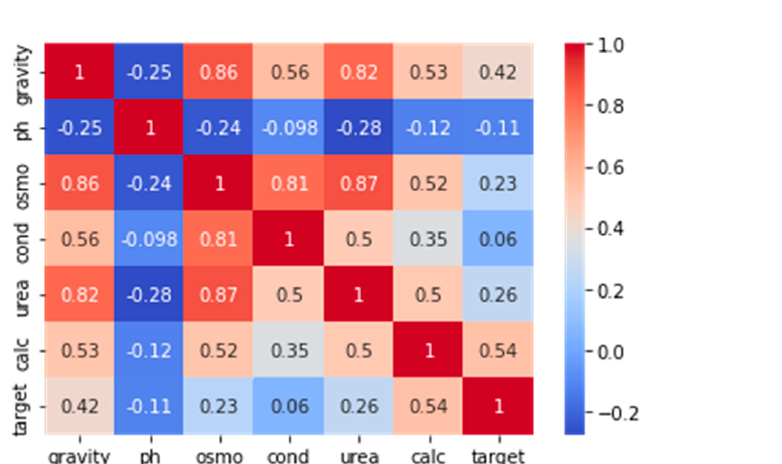
Figure 3. SNS plot.